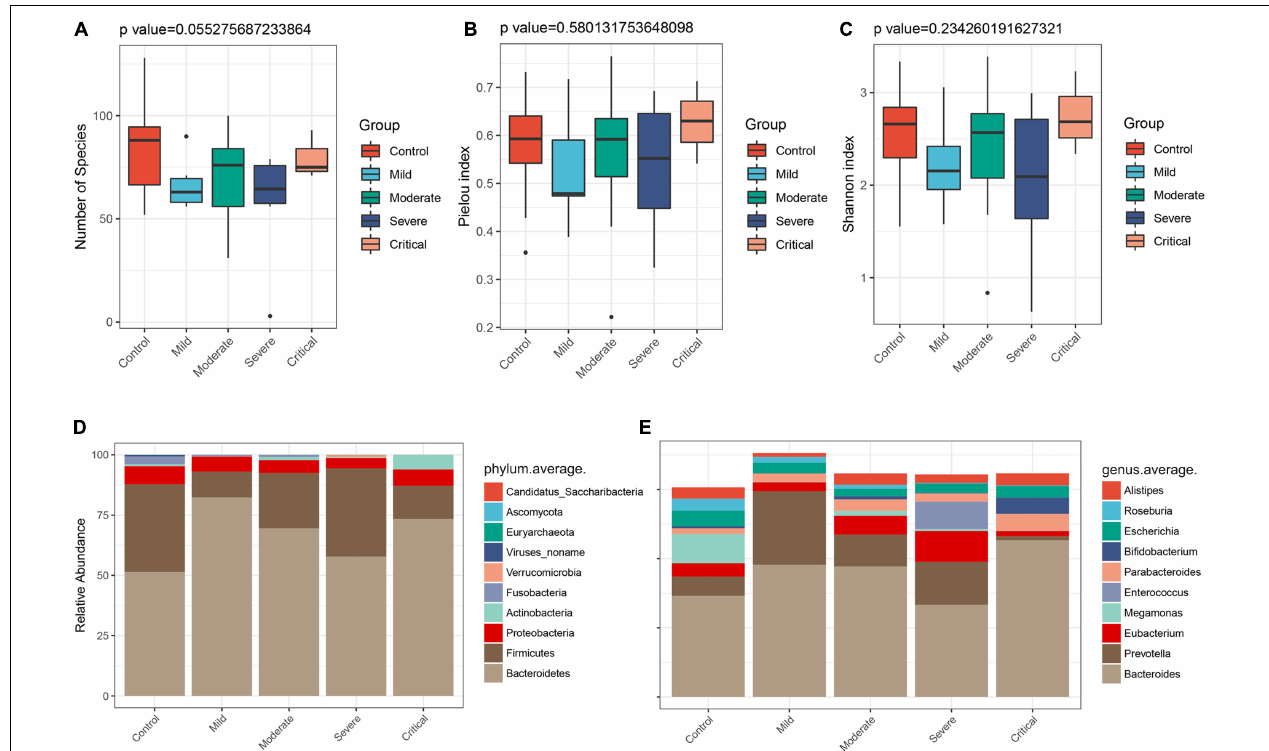
FIGURE 7 | Gut microbiome profiles differ among various clinical types. The α diversity estimated by (A) number of species ( p = 0.055), (B) Pielou index ( p = 0.580), and (C) Shannon index ( p = 0.234). (D) Average compositions and relative abundance of the bacterial community in four groups at the phylum level and (E) at the genus